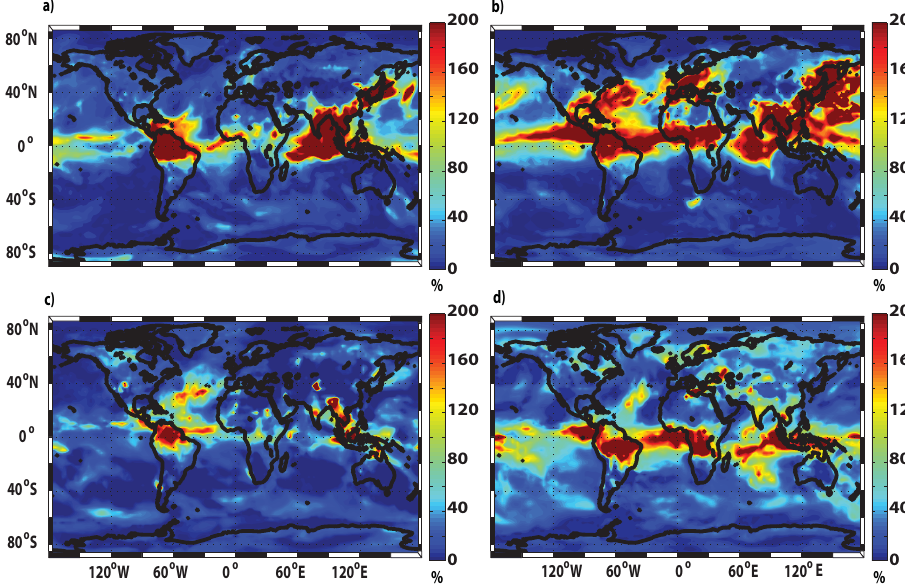
Fig. 7. Model-predicted percent change in seasonally averaged Fe d deposition rates due to the implementation of oxalate-promoted Fe dissolution for (a) March–May (MAM), (b) June–August (JJA), (c) September–November (SON), and (d) December–February (DJF).